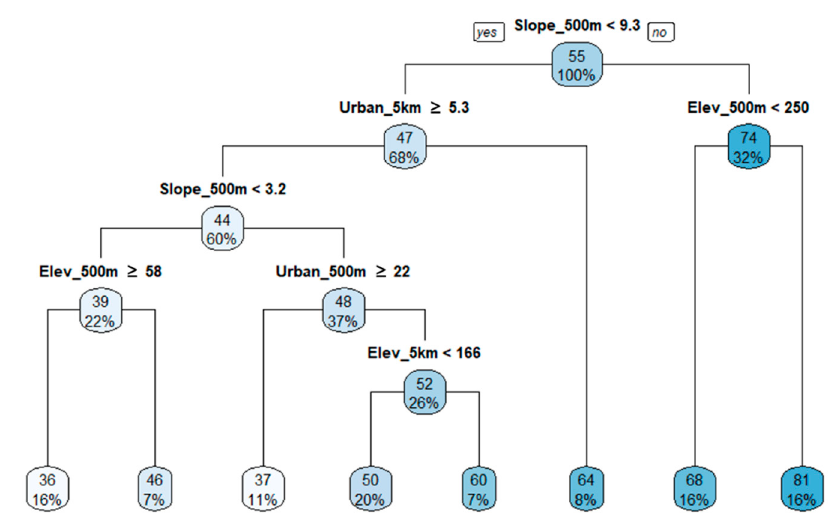
Figure 7. Regression tree for FAI with stream topographical variables and proportions of green and urban areas in buffer areas (R 2 = 0.72). The numbers located on top in color boxes are mean values of FAI.